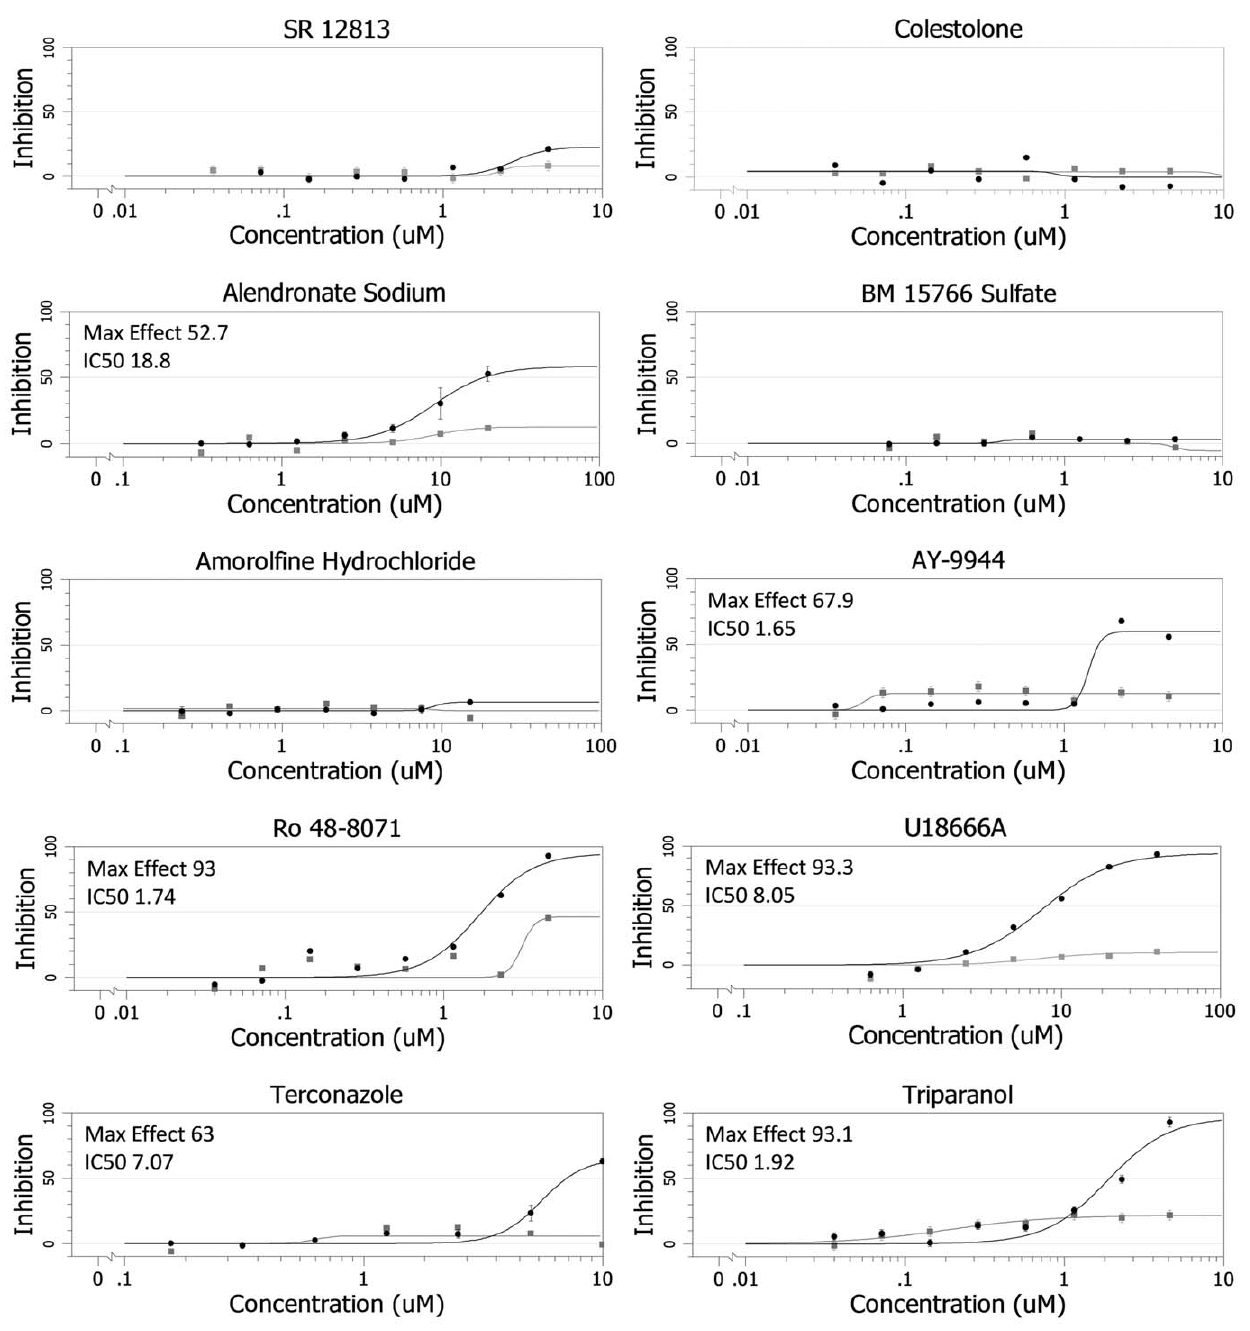
Figure 1. Effects of Sterol Pathway Inhibitors on EBOV Infection. Dose response curves for the indicated sterol pathway inhibitors are shown. The compounds were evaluated, in parallel at the indicated concentrations, for their ability to inhibit EBOV infection (black) and for inhibition of cell proliferation (gray) in Vero cells. The maximal % inhibition and the IC 50 ( m M) for their effects on EBOV infection are indicated. Data for clomiphene are presented in Johansen, et al. (manuscript in